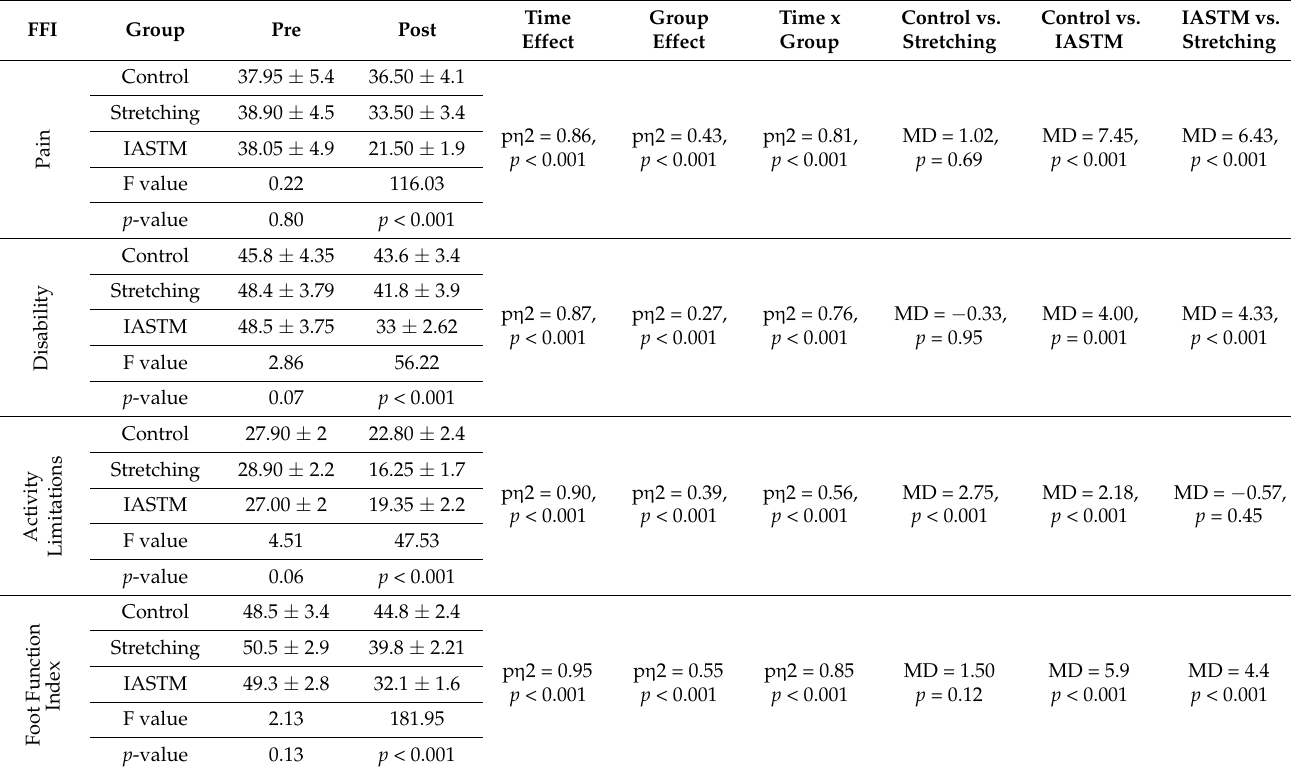
Table 1. Foot function index (FFI) and its